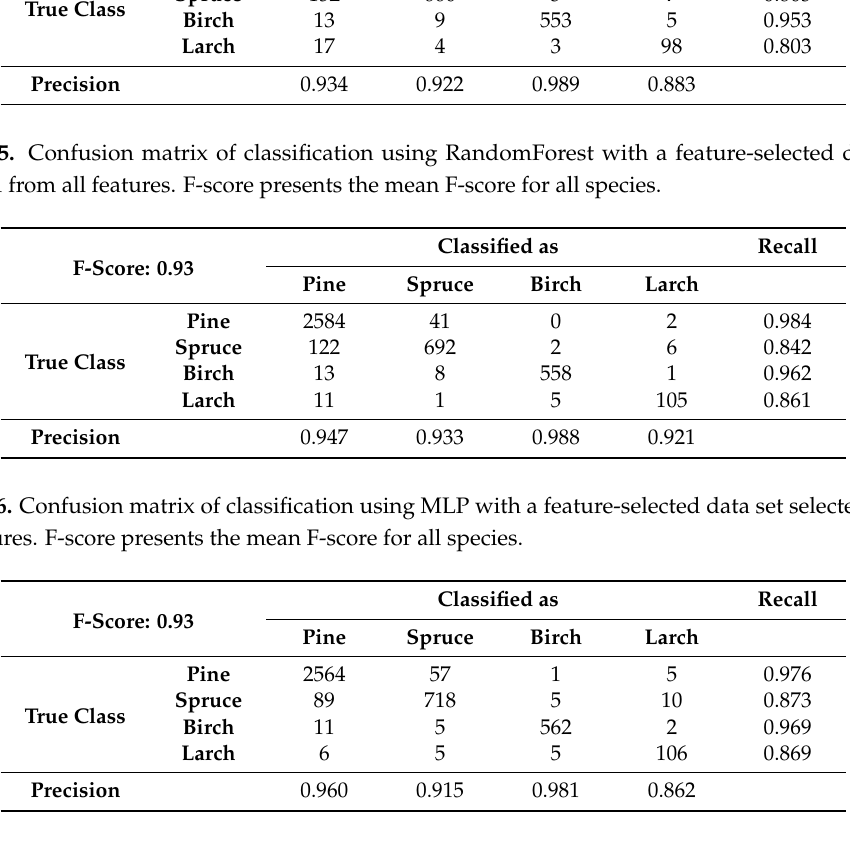
Table 17. Confusion matrix of classification using RandomForest with a feature-selected data set without normalized spectral features. F-score presents the mean F-score for all